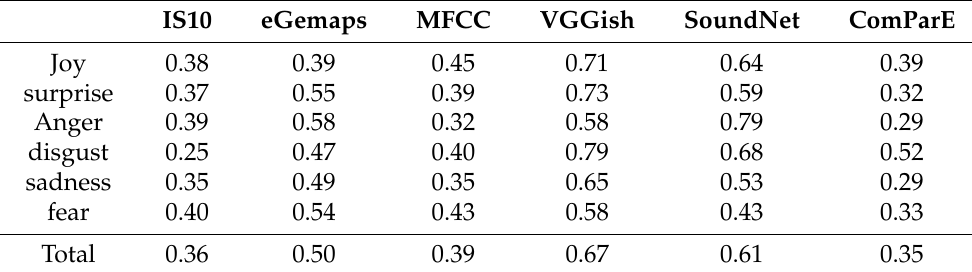
Table 3. Per-Class Emotions accuracy of multiple features on eNTERFACE05